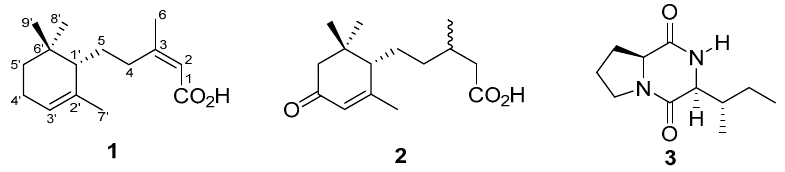
Figure 1. Abscisic acid derivatives and cyclodipeptide from Roussoella sp. MFLUCC 17-2059.